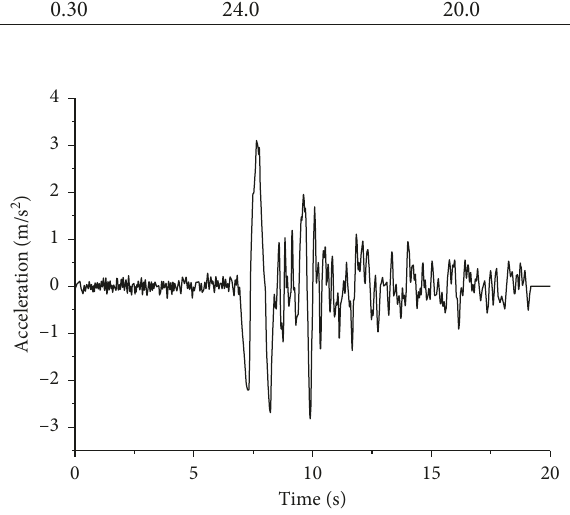
Figure 6: Tianjin wave acceleration time